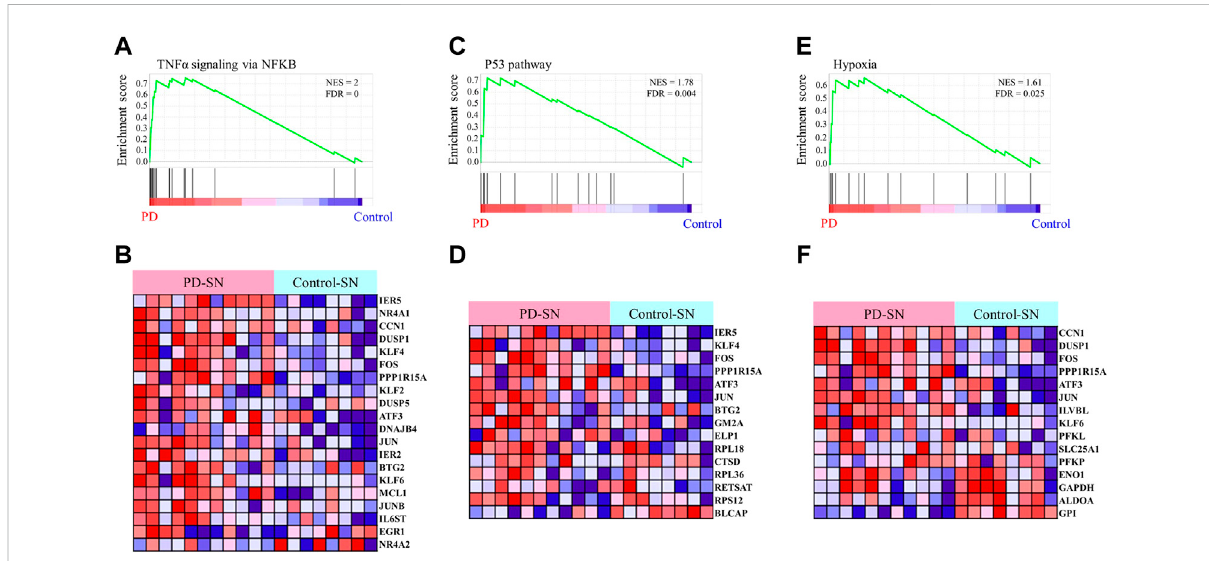
FIGURE 5 GeneSetEnrichmentAnalysisoftheEASRco-expressionnetwork.TheanalysisdemonstratesthatTNF- α signalingviaNF- κ B (A,B) ,P53pathway (C,D) , and hypoxia (E,F) are signi fi cantly enriched in substantia nigra of PD phenotype. FDR < 0.05 was considered as a statistically signi fi cant